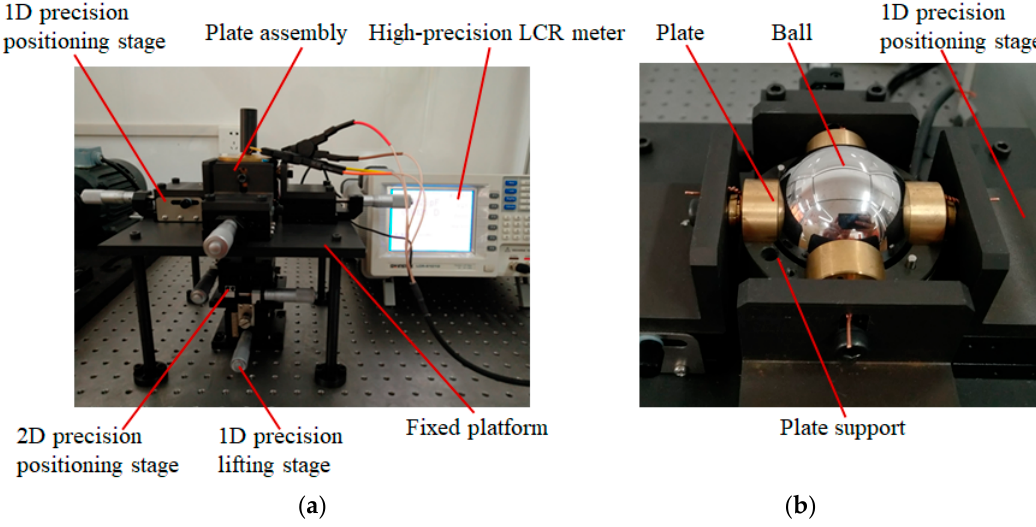
Figure 7. Experimental setup ( a ) Photograph of the test rig, ( b ) photograph of plate assembly.